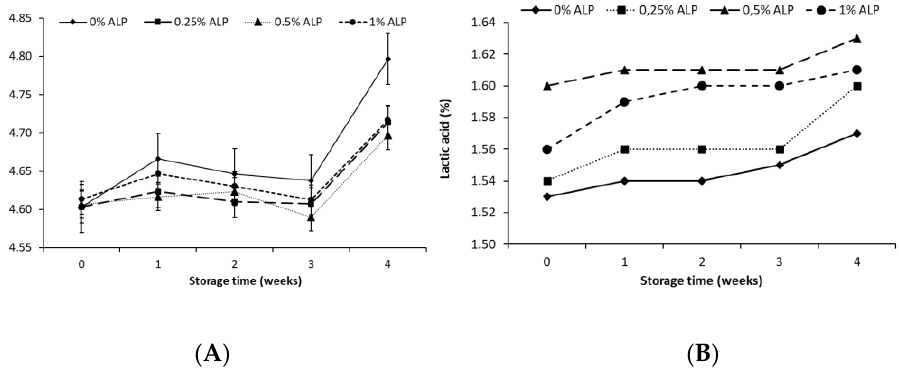
Figure 3. Value of pH ( A ) and titratable acidity ( B ) of acid curd cheese with different addition (0–1%) of astaxanthin lipid preparation (ALP) during 4 weeks of refrigerated storage (5 ± 1 °C). The titratable acidity of a fresh tvarog (a control sample) on the day of starting the tests was 1.53% (Figure 3B). For every one percent of ALP addition, the acidity of the ACC significantly increased by 0.7% lactic acid, except for the difference between the control sample and the tvarog with the lowest ALP content. During storage, the acidity of all sam- ples increased. For the control sample, the acidity increased by 0.4% after 4 weeks, with a characteristic stabilization between the 1st and 2nd weeks of storage. The addition of ALP prolonged the acidity stabilization time in the ACCs by one week (to the 3rd week). This may indicate the bacteriostatic properties of astaxanthin against lactic acid bacteria [44]. During 4 weeks of storage, the acidity least increased by 0.3% in the ACC containing 0.5% ALP, while it increased by 0.5 – 0.6% in the other samples. Correlation analysis showed that the pH value almost fully positively correlates (r = 0.917 – 0.944) with the acidity of the ACCs containing 0 and 0.25% ALP. The addition of 0.5 and 1% ALP reduced the value of the correlation coefficient to 0.889 and 0.580, respectively. This may confirm the inhibitory effect on lactic acid production by bacteria and/or the buffering effect of the substances contained in the astaxanthin preparation. The statistical analysis confirmed the significant effect of the storage time and ALP addition on the titratable acidity of the ACC. Peroxide value (PV) in the control sample was 0.87 mg MDA (Figure 4A). The addi- tion of ALP in amounts of 0.25% and 0.5% did not significantly affect the content of lipid peroxidation products in ACCs. Only the addition of 1% ALP reduced the PV of tvarog to 0.74 mg MDA. During 3 weeks of storage, the content of secondary lipid peroxidation products in the control samples and those containing 0.25 – 0.5% ALP alternately decreased and increased, and then stabilized over a period of 3 – 4 weeks. In these ACCs, after 3 and 4 weeks of storage, the PV values were lower than before refrigerated storage of the sam- ples. The average PV value in all samples was 0.77 mg MDA, indicating a very low level